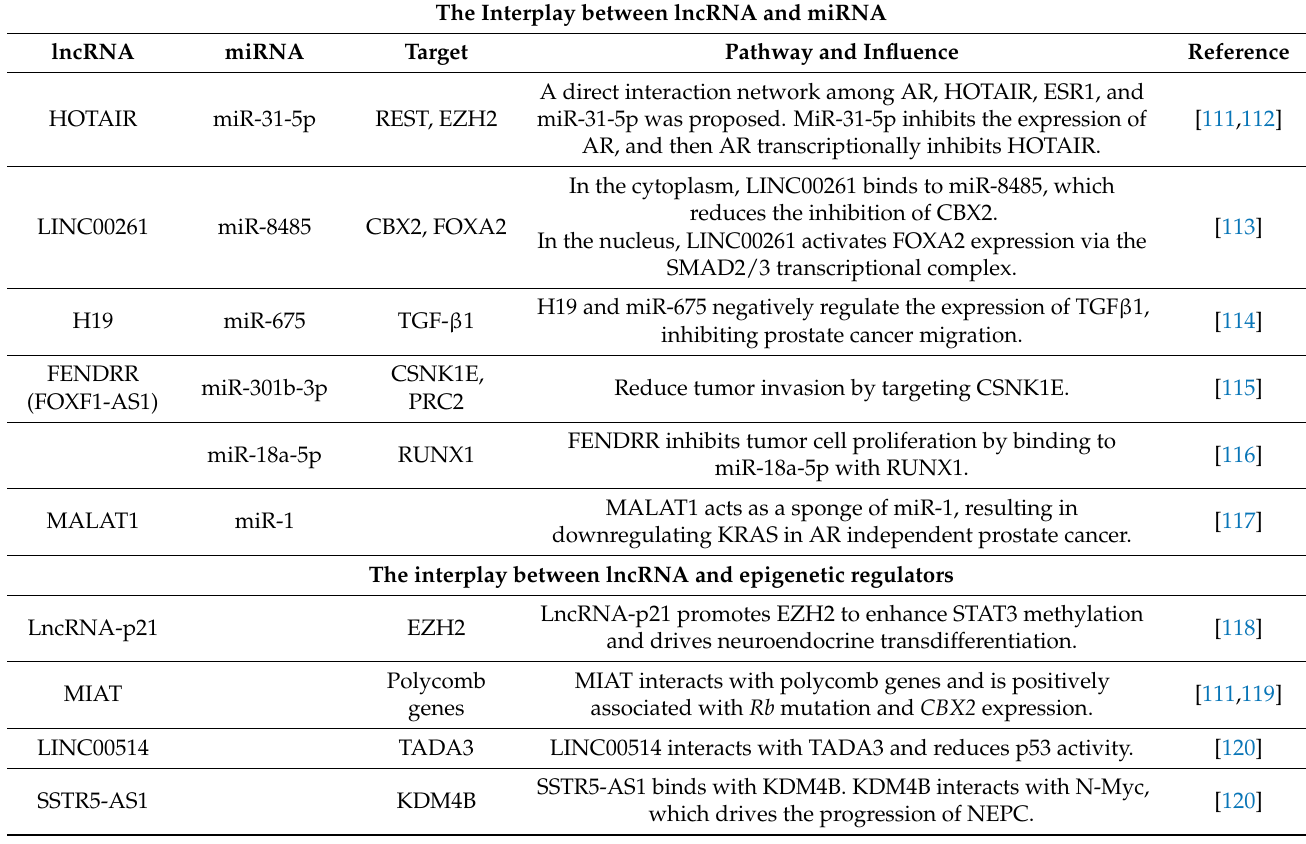
Table 2. The interplay between lncRNA and miRNA/epigenetic regulators in NEPC. The Interplay between lncRNA and